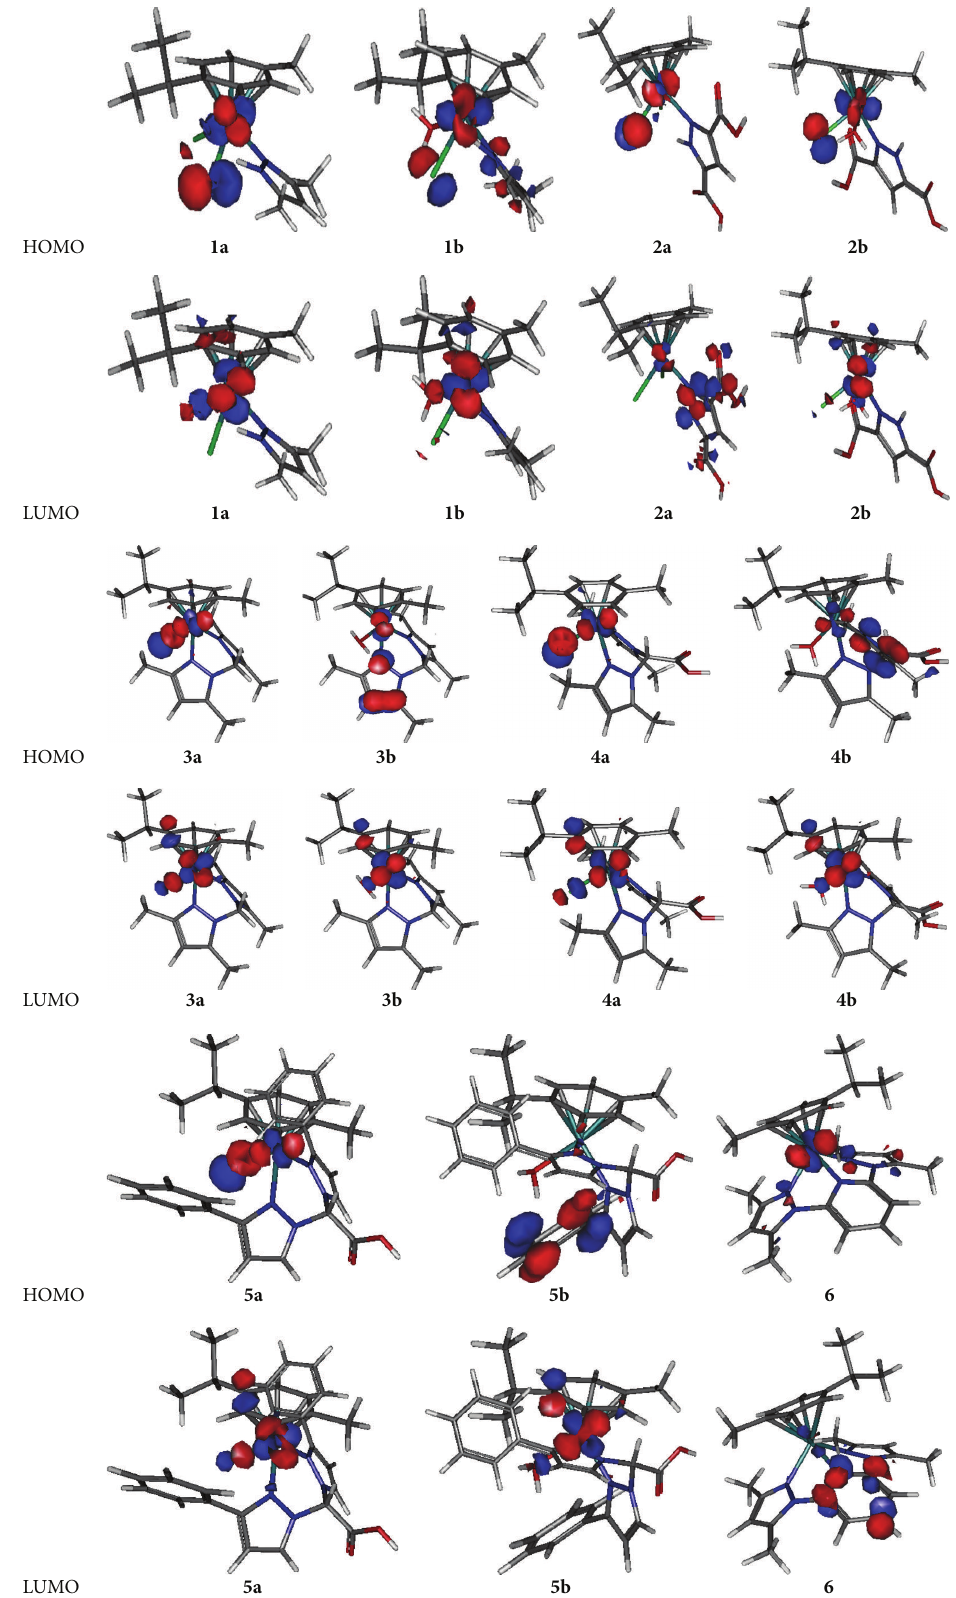
Figure 4: The HOMO and the LUMO features of the compounds constructed with isovalue of